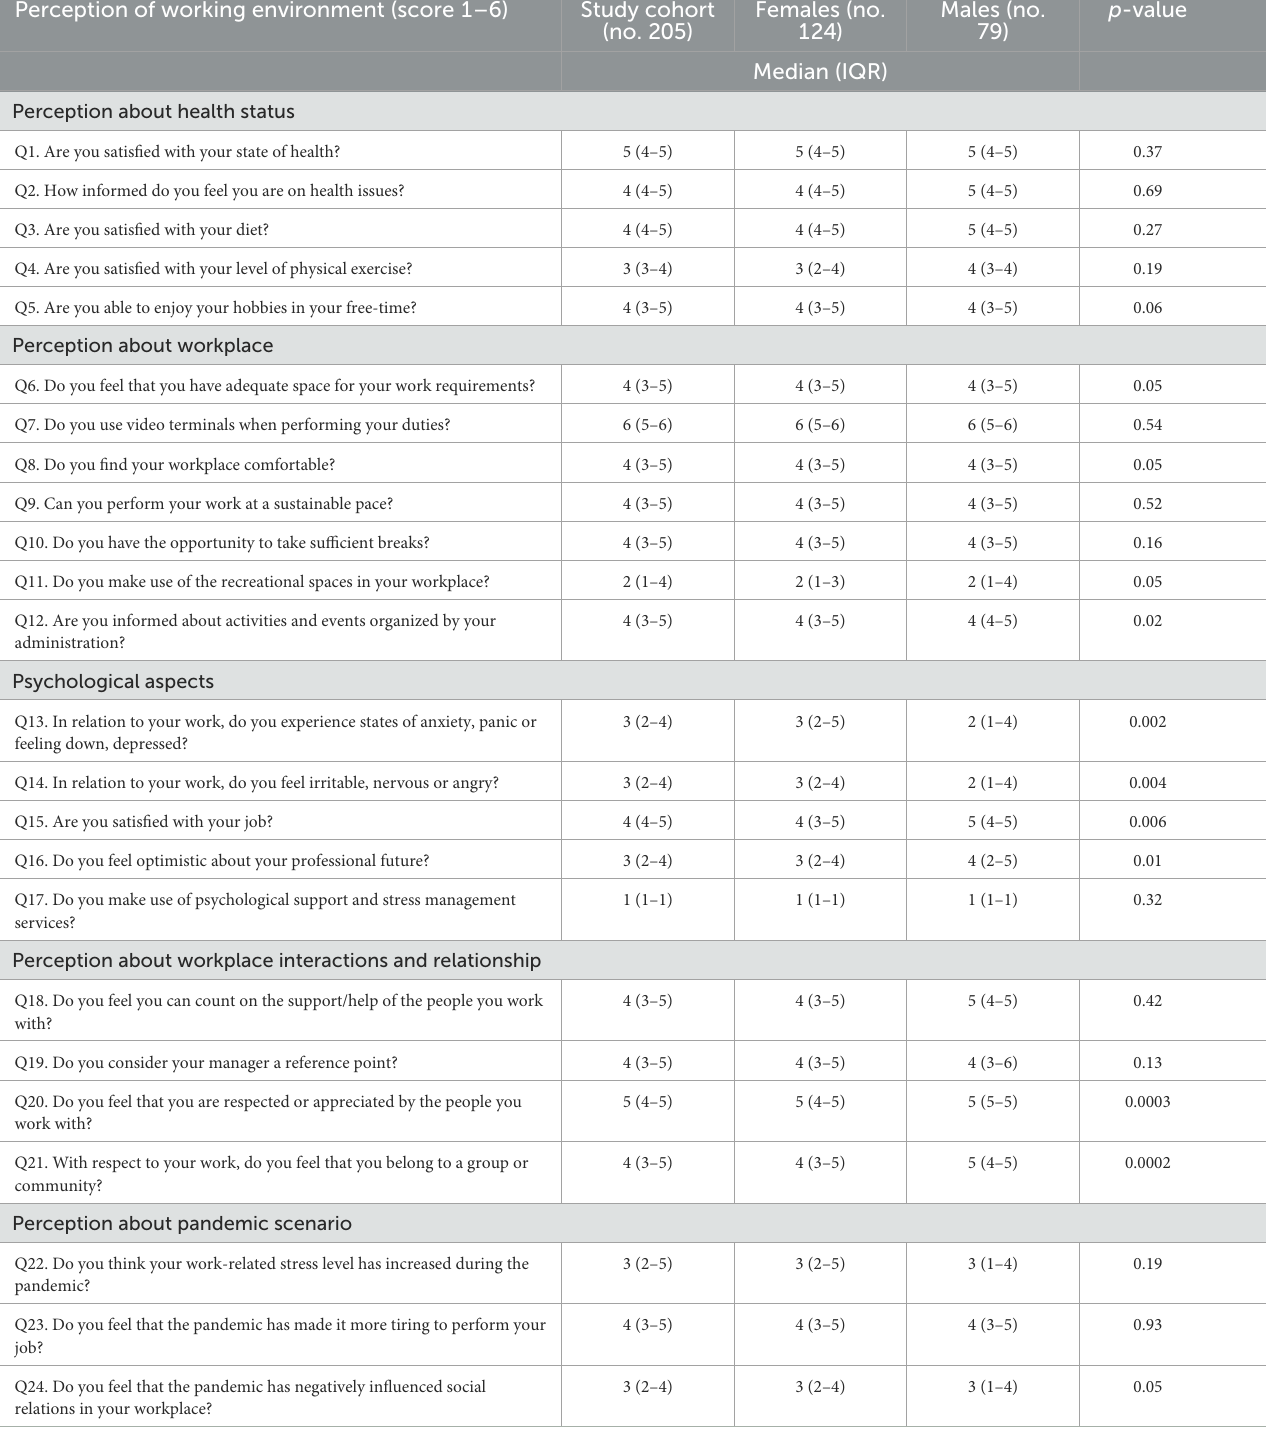
TABLE 2 Median and IQR values for the 24